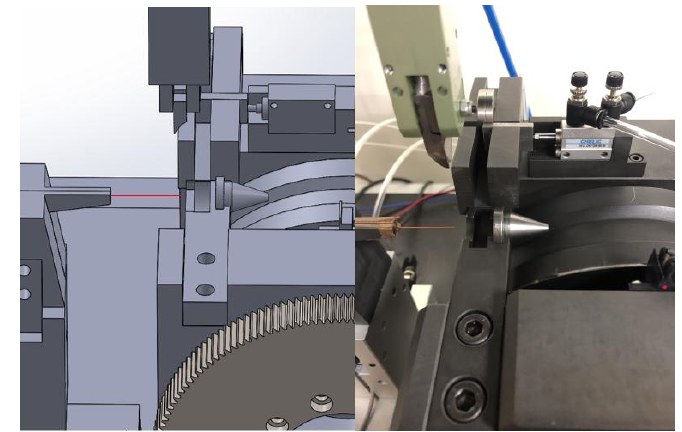
7 of 16 Step7: The cut wire wasdelivered forward a certain distance for falling down whengripper 2